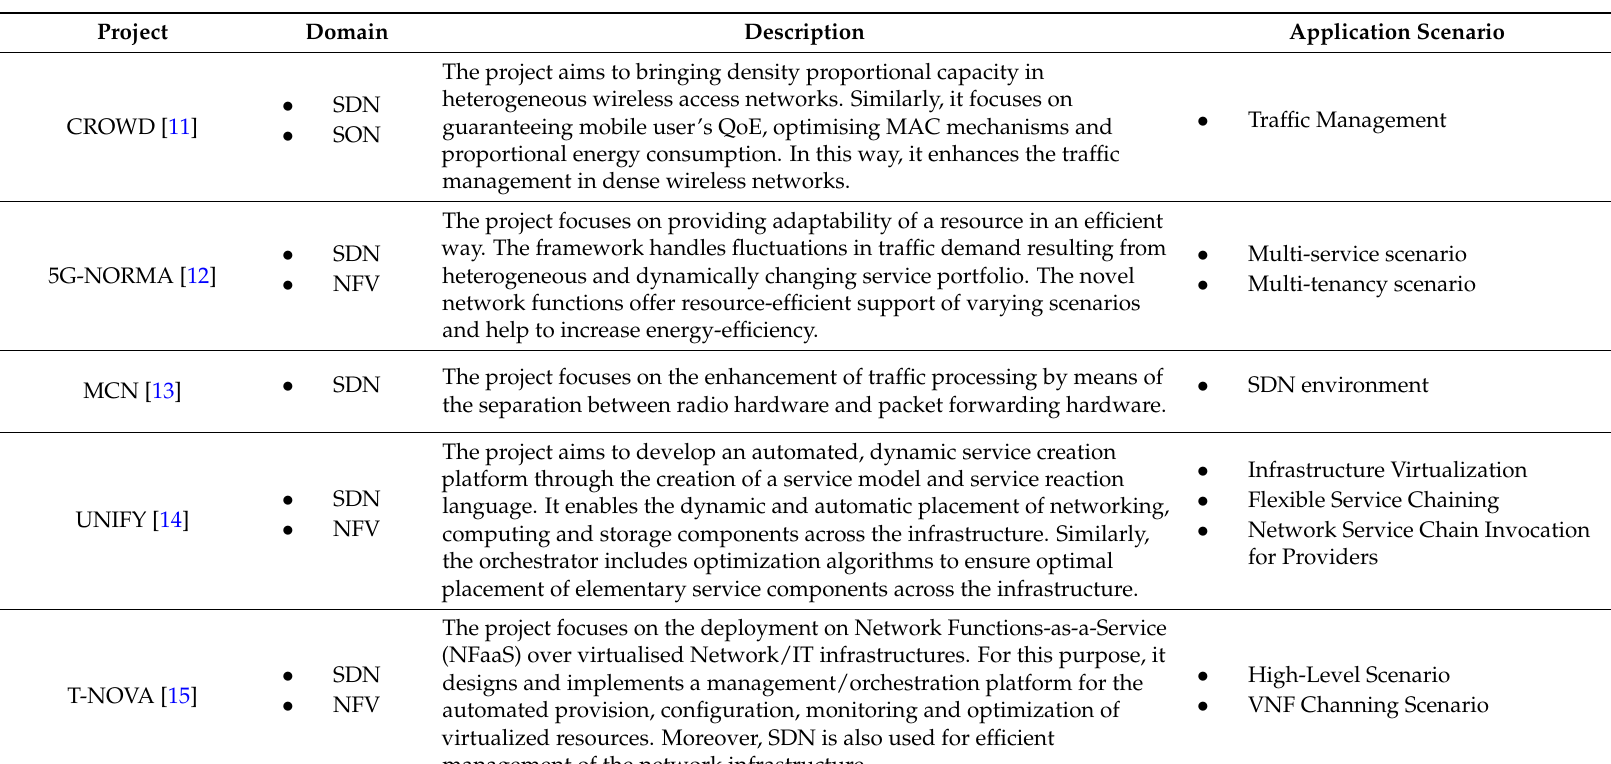
Table 1. SDN/NFV based management ongoing